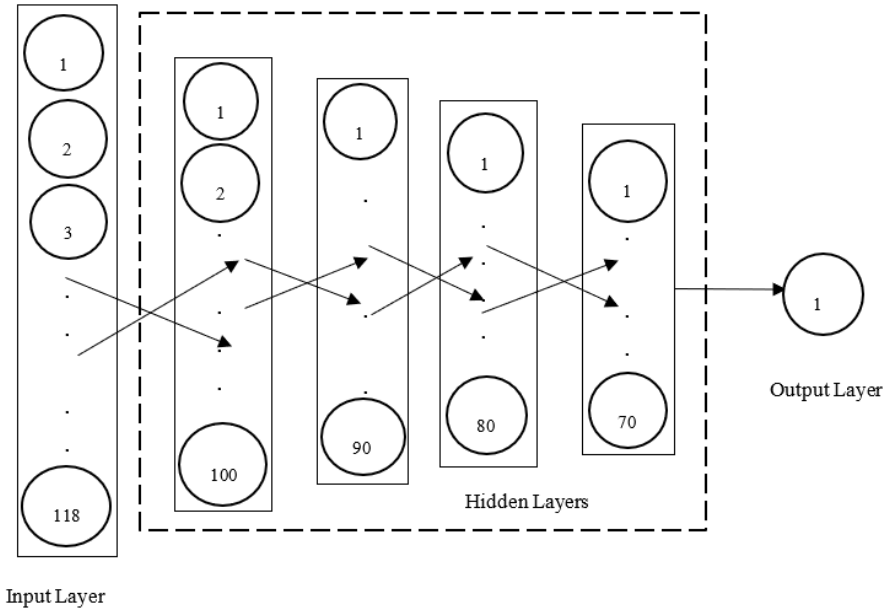
Figure 5. Deep ANN classifier (binary classification). Table 4. Performance metrics for different learning rates (binary